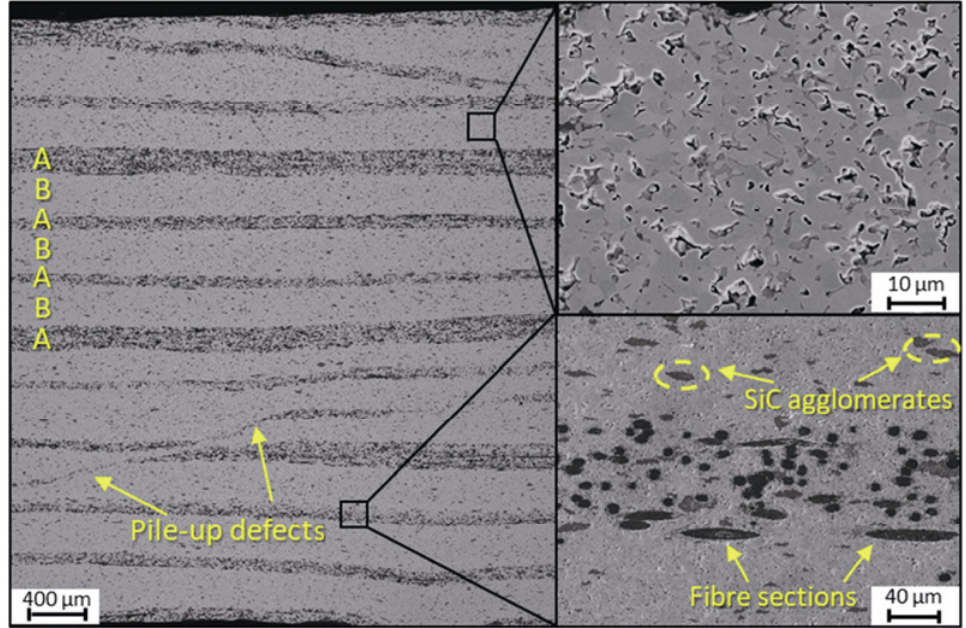
Fig. 13 Morphologies of graded sample (L2) composed of alternation 20% C f -reinforced layers (A) and 0% C f layers